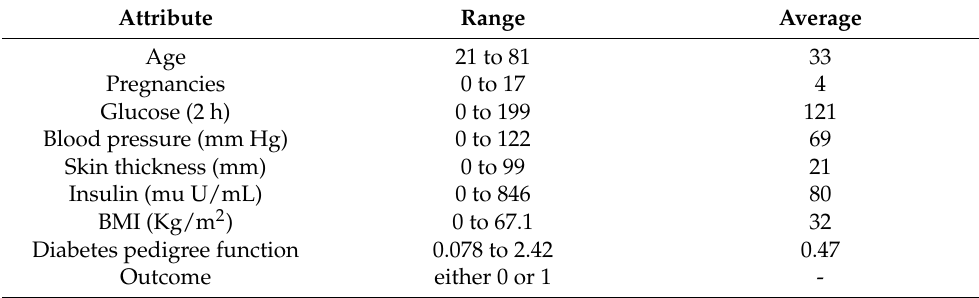
Table 1. Attributes of the